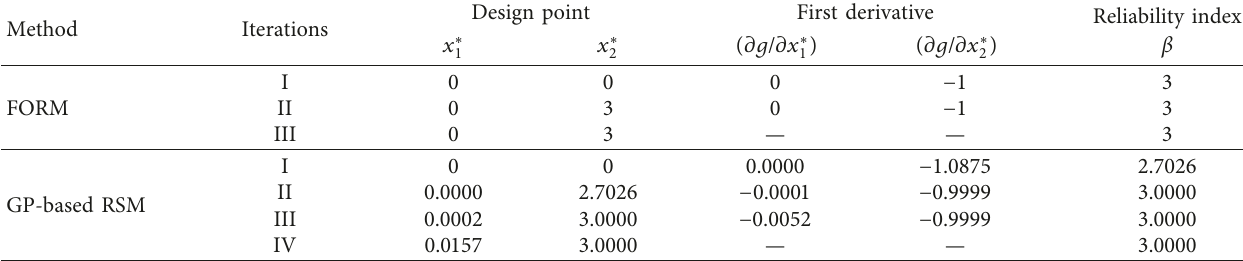
Table 2: Calculation process of the design point using FORM and the proposed method for Example 1.